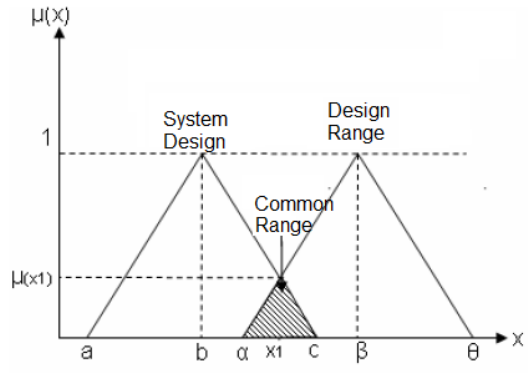
Fig. 3. Classical definition for